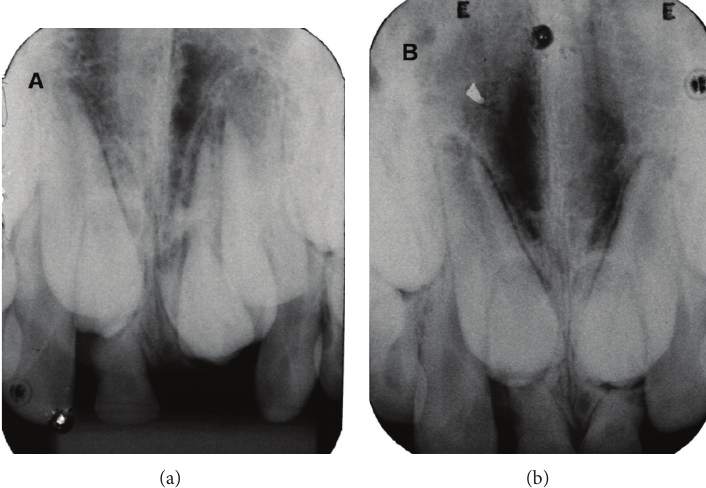
Figure 2: Periapical radiograph showing impacted permanent maxillary central incisors and the presence of two mesiodens in both twins.